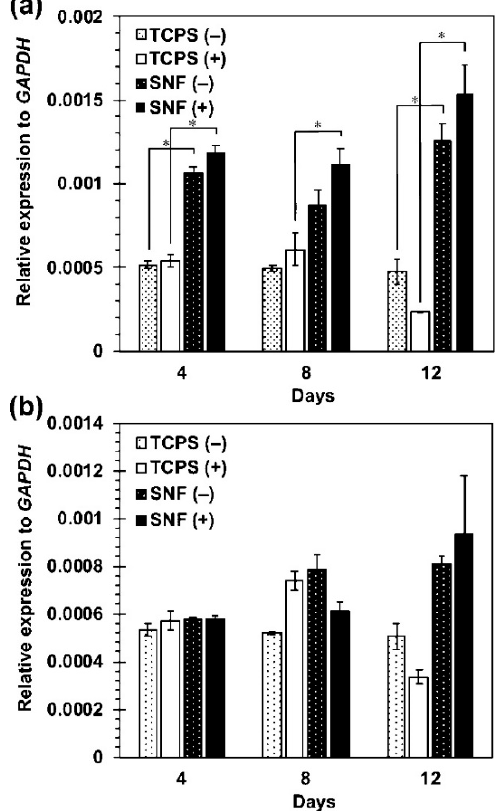
Figure 6. Expression of RUNX2 ( a ) and osteocalcin OCN ( b ) in MSCs cultured on SNFs and TCPS plates under the normal medium ( − ) and the osteogenic di ff erentiation medium (+). The signal intensity was normalized using that of a control housekeeping gene (human GAPDH gene). Data are shown as the mean ± S. E. ( n = 2). * indicates significance ( p < 0.05, Student’s t -test). ACS Omega, Iijima et al. [36].